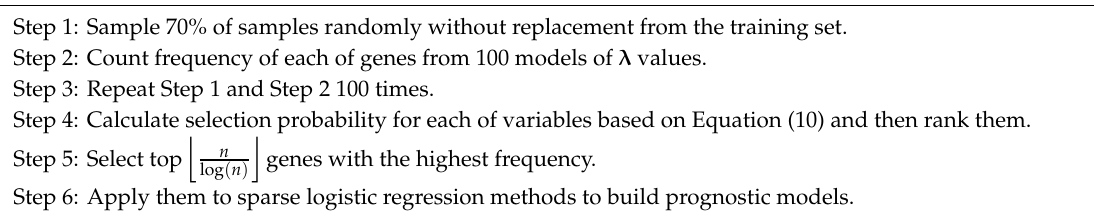
Algorithm 1 Proposed two-step procedure